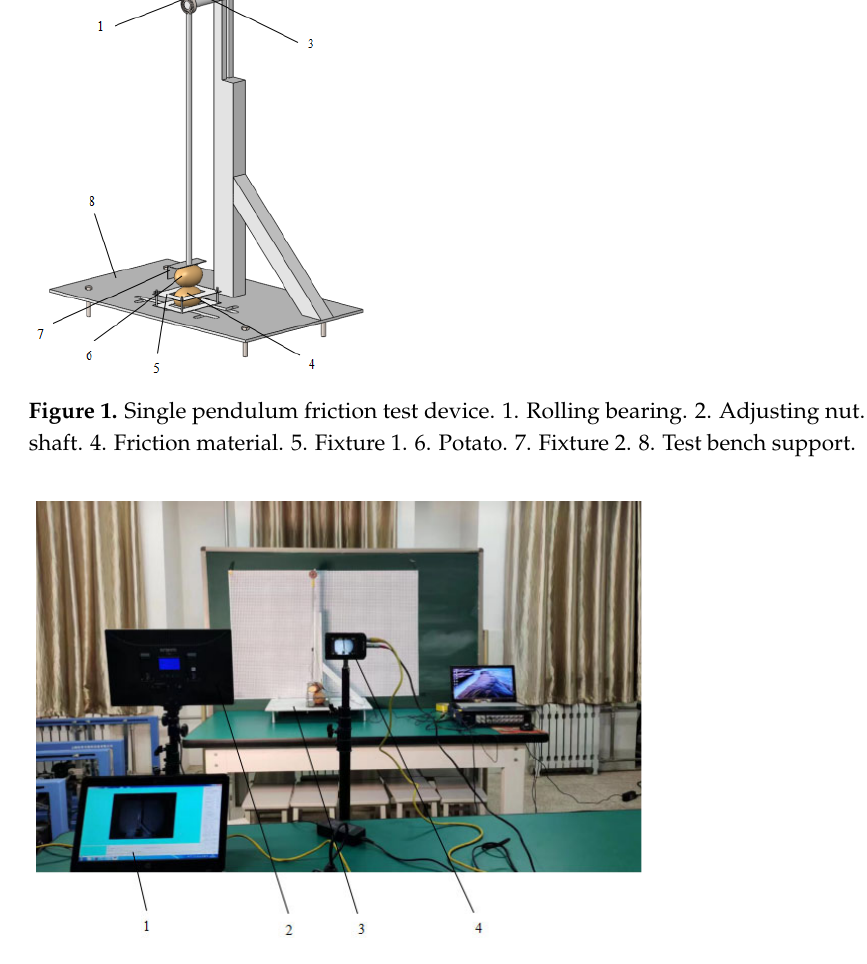
Figure 2. Friction image acquisition system. 1. Computer. 2. Flat panel light supplement. 3. Single pendulum friction test device. 4. High ‐ speed digital camera.